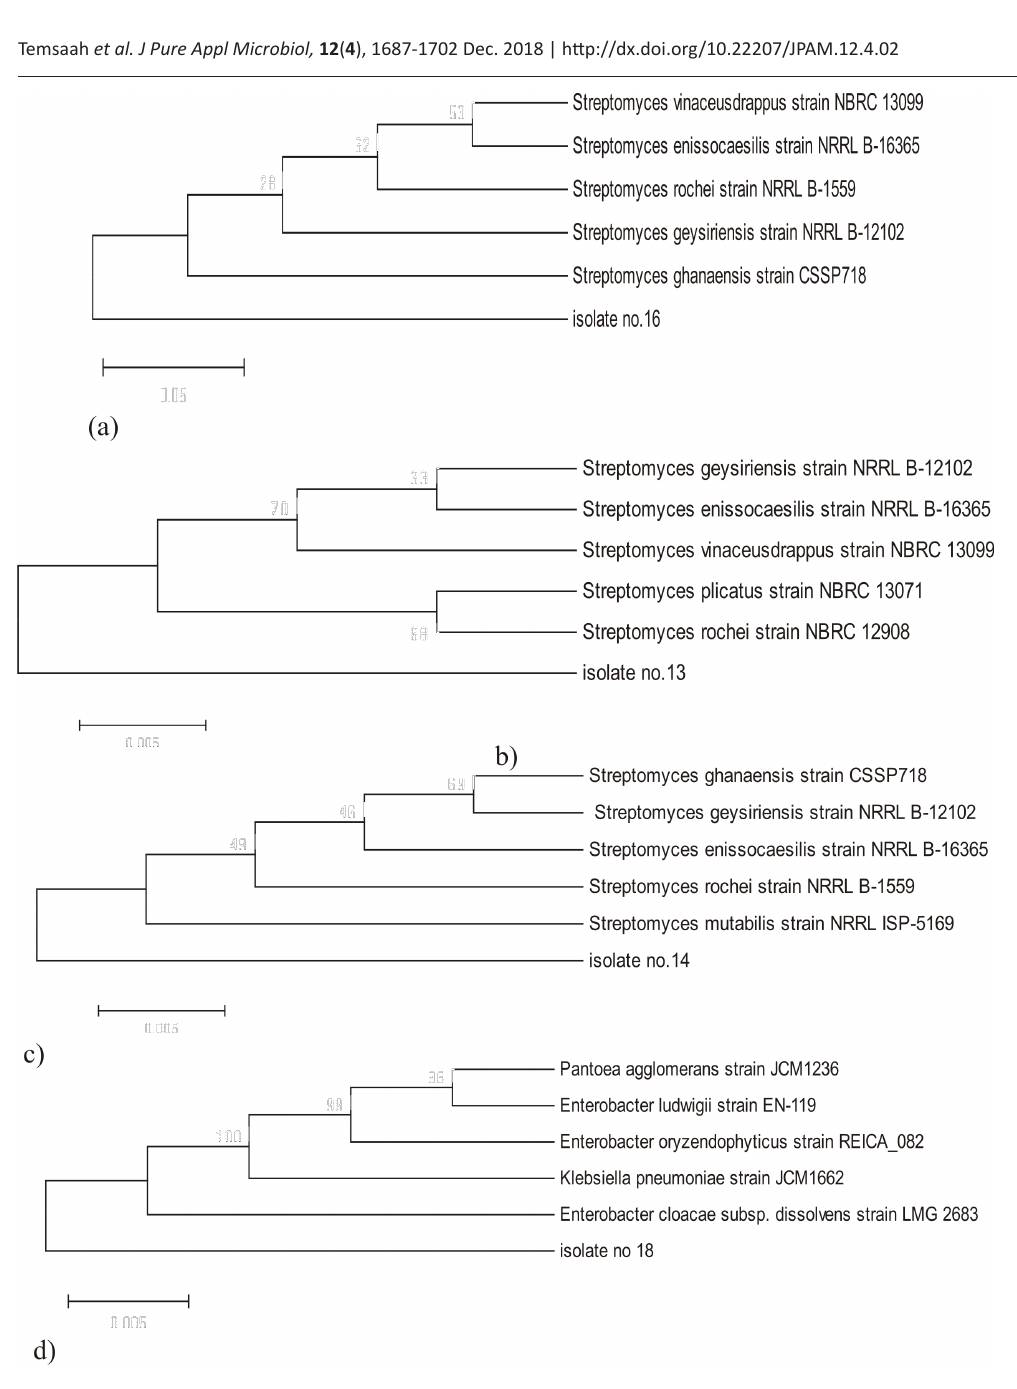
Fig. 3. Phylogenetic tree based on 16S rDNA sequence using neighbor joining tree method, bootstrap method as a test of phylogeny with 500 bootstrap replications and Kimura 2- parameter model in the Molecular Evolution Genetic Analysis (MEGA) software version 6